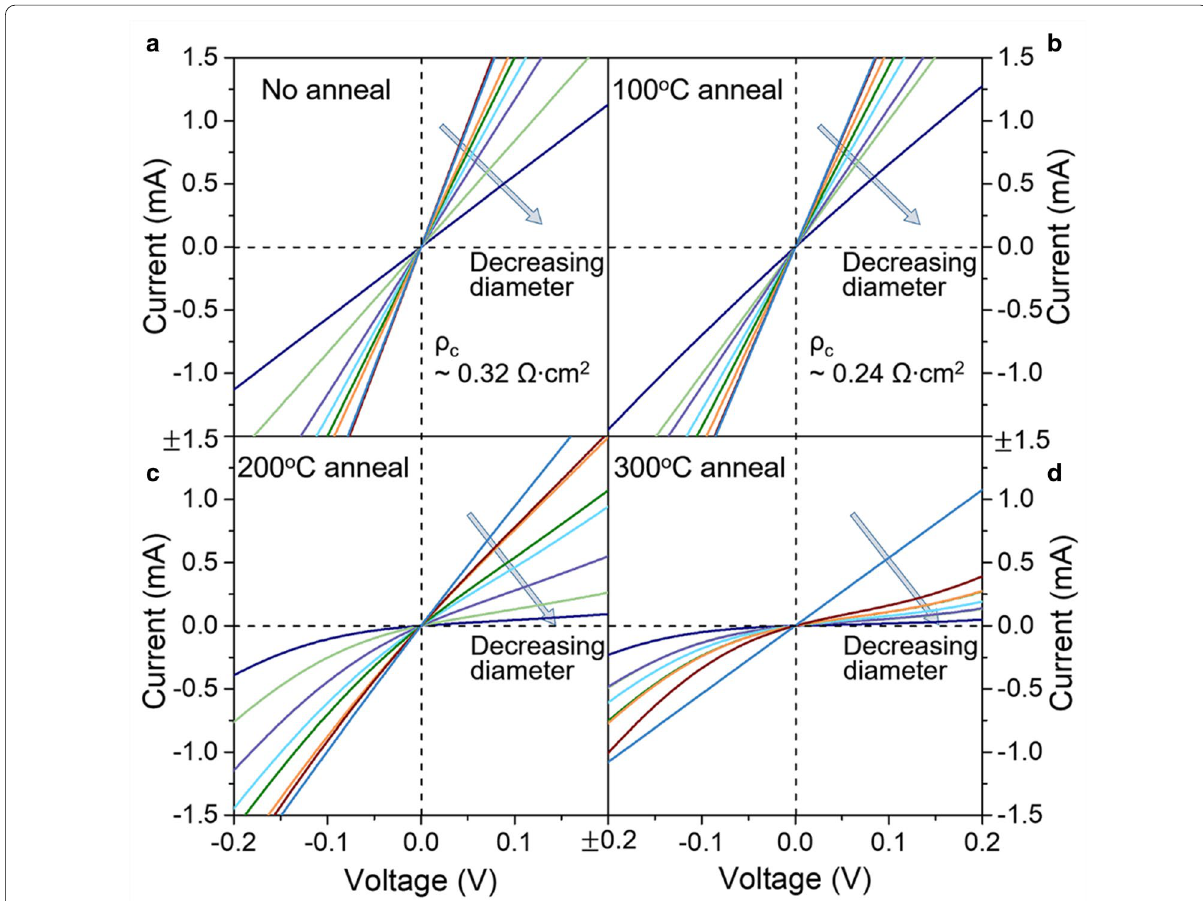
Fig. 6 Contact resistance measurements of the 10-nm-thick MoO X films on polished silicon wafers a without post-annealing, with post-annealing at b 100 °C, c 200 °C and d 300